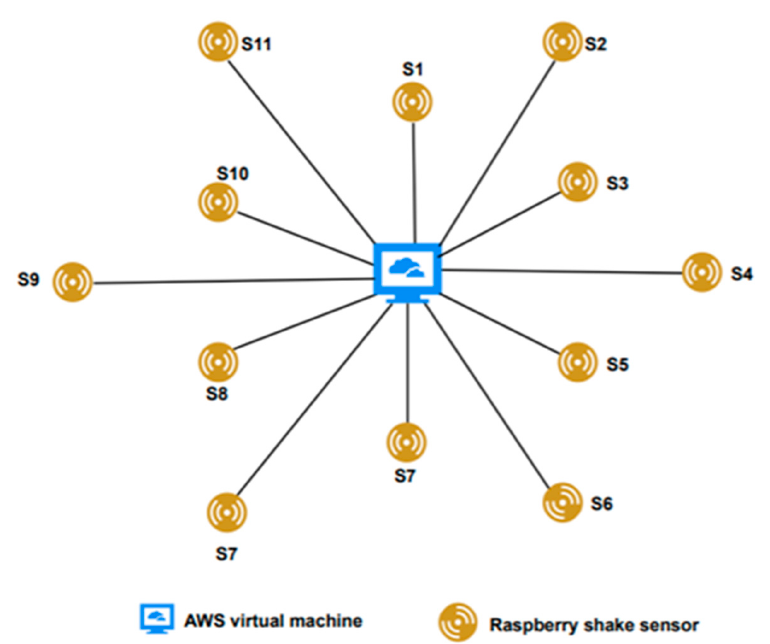
Figure 7. Centralised processing architecture using the AWS virtual machine.